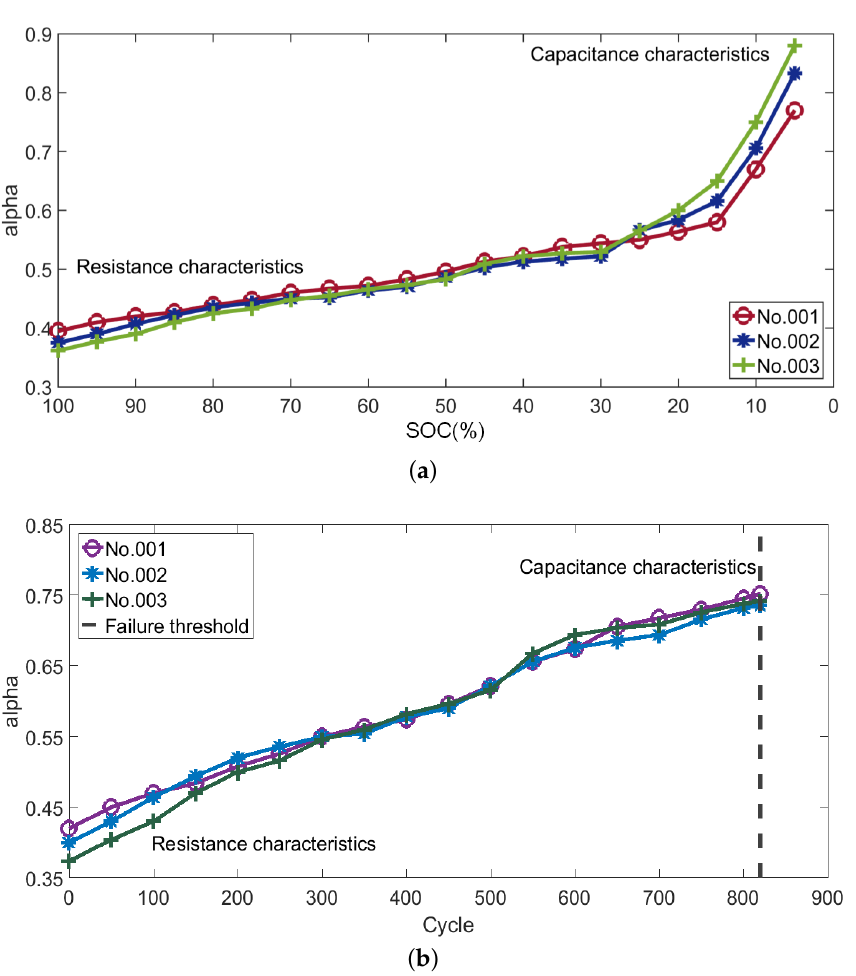
Figure 7. Identified FDO of the proposed battery model ( C f = 1000): ( a ) at different SOCs; ( b ) at different cycle